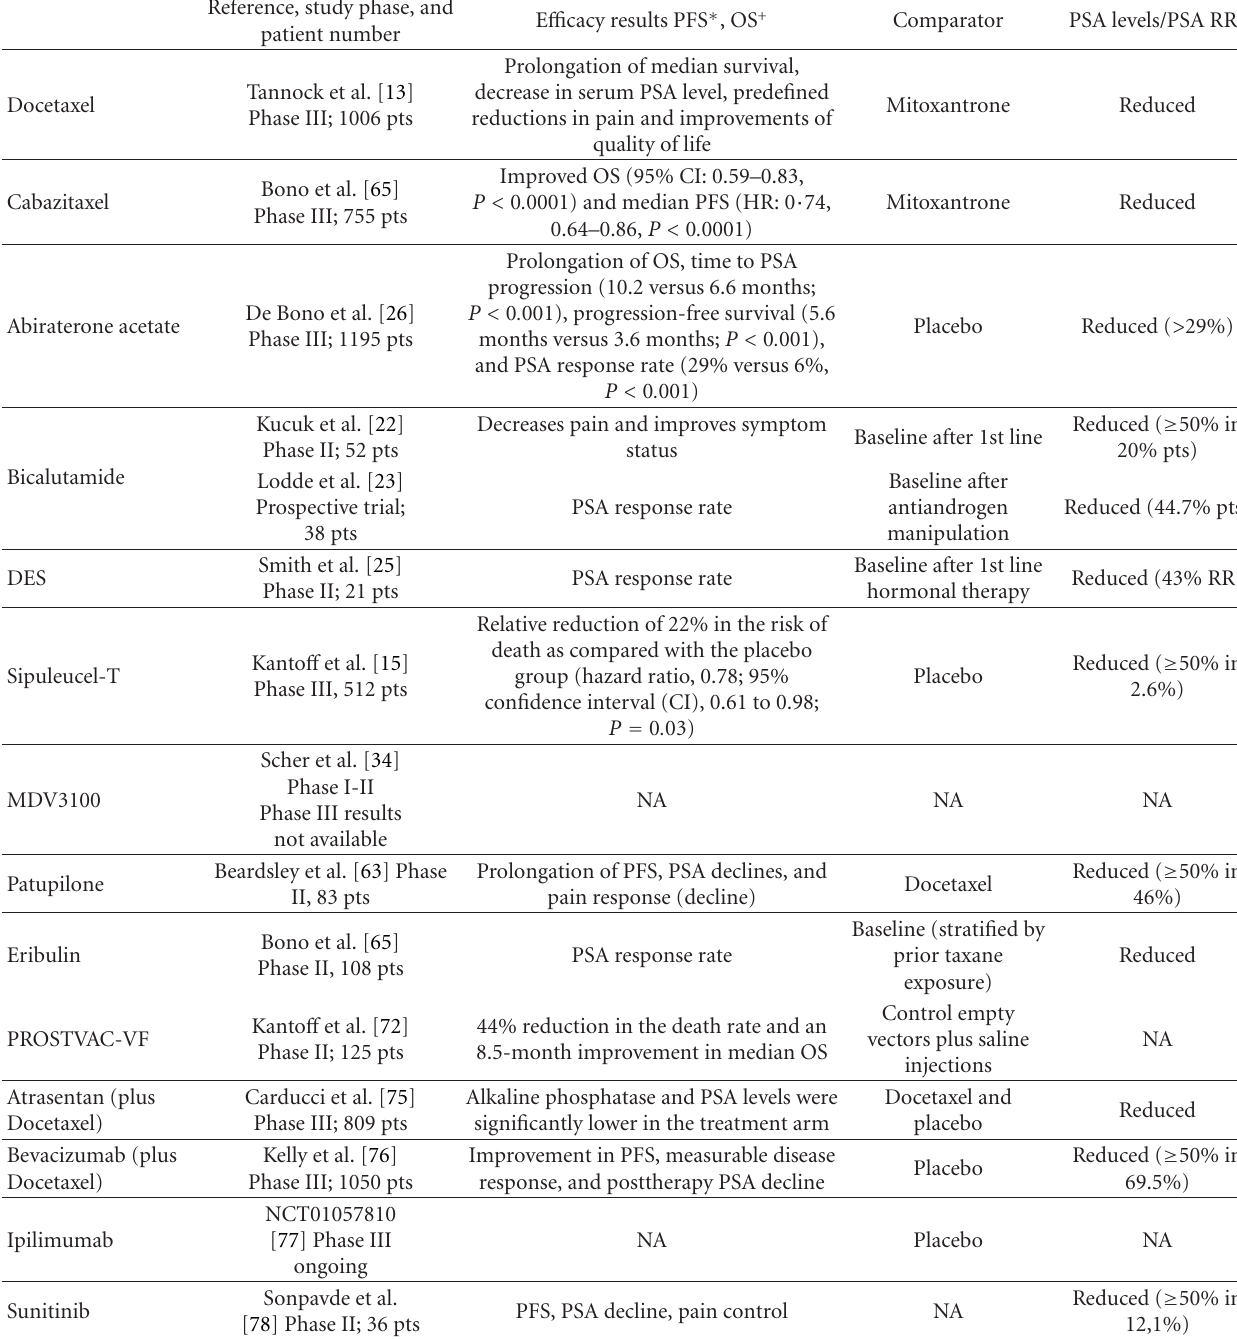
Table 1: Summary of the therapeutic impact of new drugs in CRPC